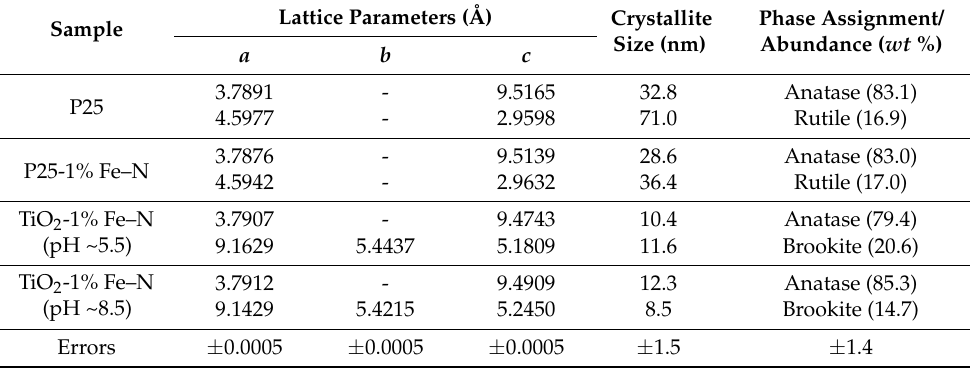
Table 1. Lattice parameters, crystallite size, phase assignment, and relative abundance of the P25 and hydrothermally-synthesized samples.